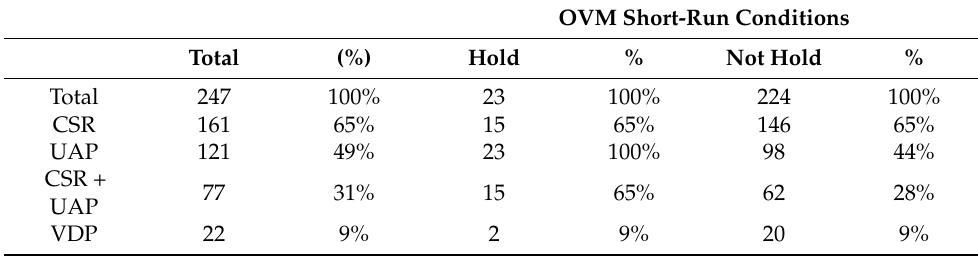
Table 4. Short-run conditions